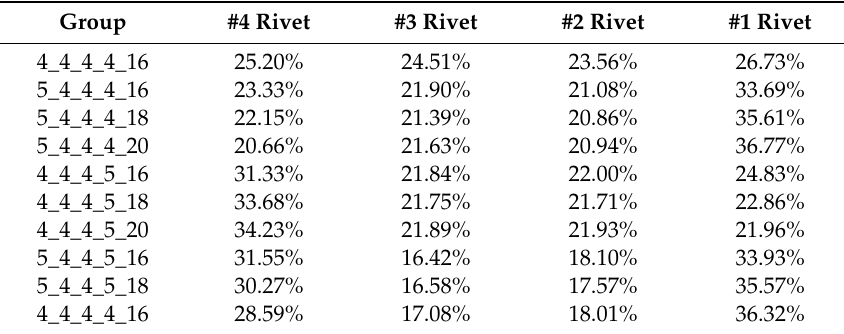
Table 4. The ratio of rivet loads to tensile load of di ff erent groups of riveted lap joints.